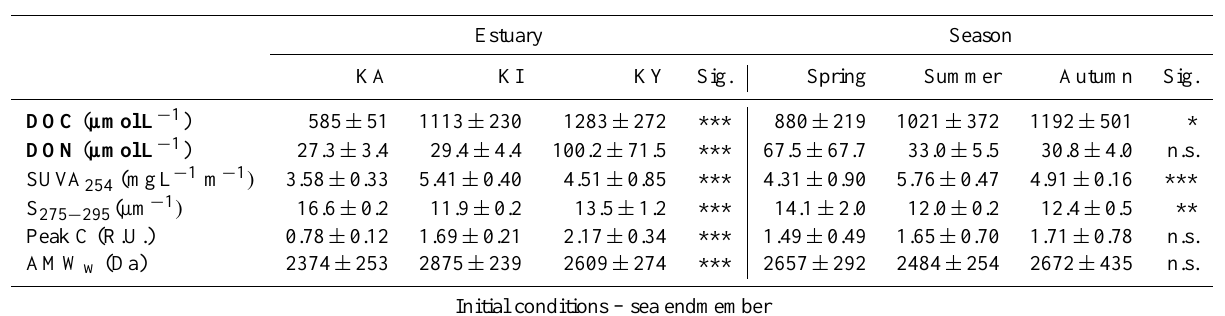
Table 2. Initial conditions and cumulative changes ( 1 ) of DOM parameters during the 12–18d dark incubations: average DOC and DON concentrations, DOC-specific UV absorbance at 254nm (SUVA 254 ), average slope coefficient between 275 and 295nm, fluorescence inten- sity of peak C and weighted averages of apparent molecular weight. Whole data is divided by study estuaries and seasons. “Estuary” includes all seasons, “Season” includes all estuaries. KA: Karjaanjoki, KI: Kiiminkijoki and KY: Kyrönjoki. Significance level of differences between groups (Sig.) as analyzed by ANOVA is also given: *– < 0.05, ** < 0.01, *** < 0.001, n.s.: not significant. Quantitative variables are in bold, as qualitative variables are